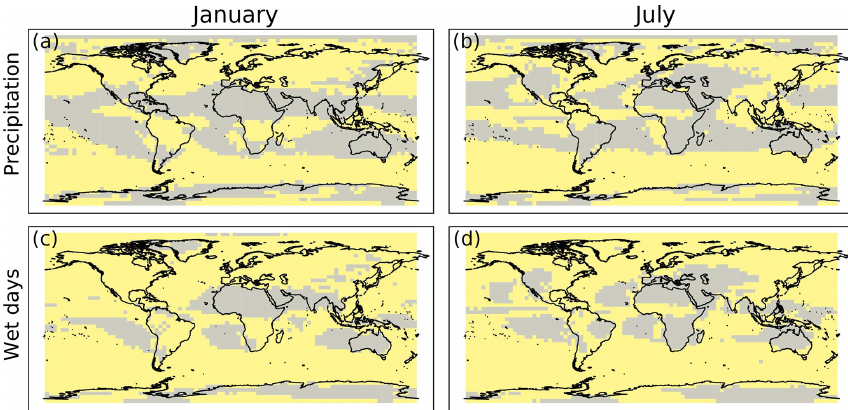
Figure 8. Outcome of the Shapiro–Wilk test for normality for precipitation (a, b) and the number of wet days (c, d) in January (a, c) and July (b, d) . The grey area shows where the null hypothesis of normality is rejected ( p < 0 .